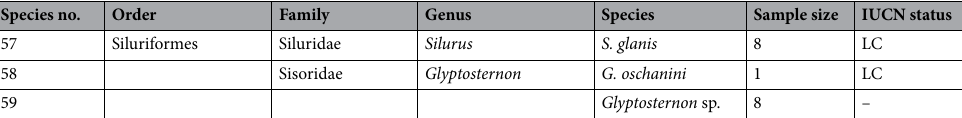
Table 1. Classification, sample size and INCN status of the fish species of Uzbekistan using in this study. IUCN International Union for Conservation of Nature, CR critically endangered, EN endangered, VU vulnerable, NT near threatened, LC least concern, DD data deficient, − no assessment.